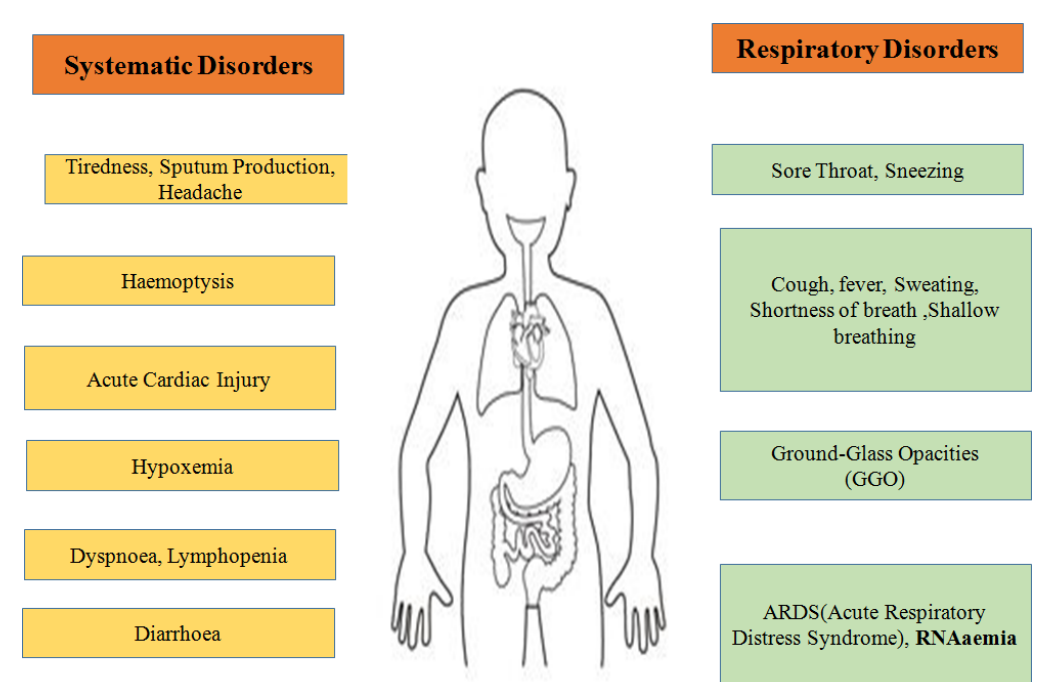
FIGURE 4 - Common symptoms associated with coronavirus infectionsStructure of